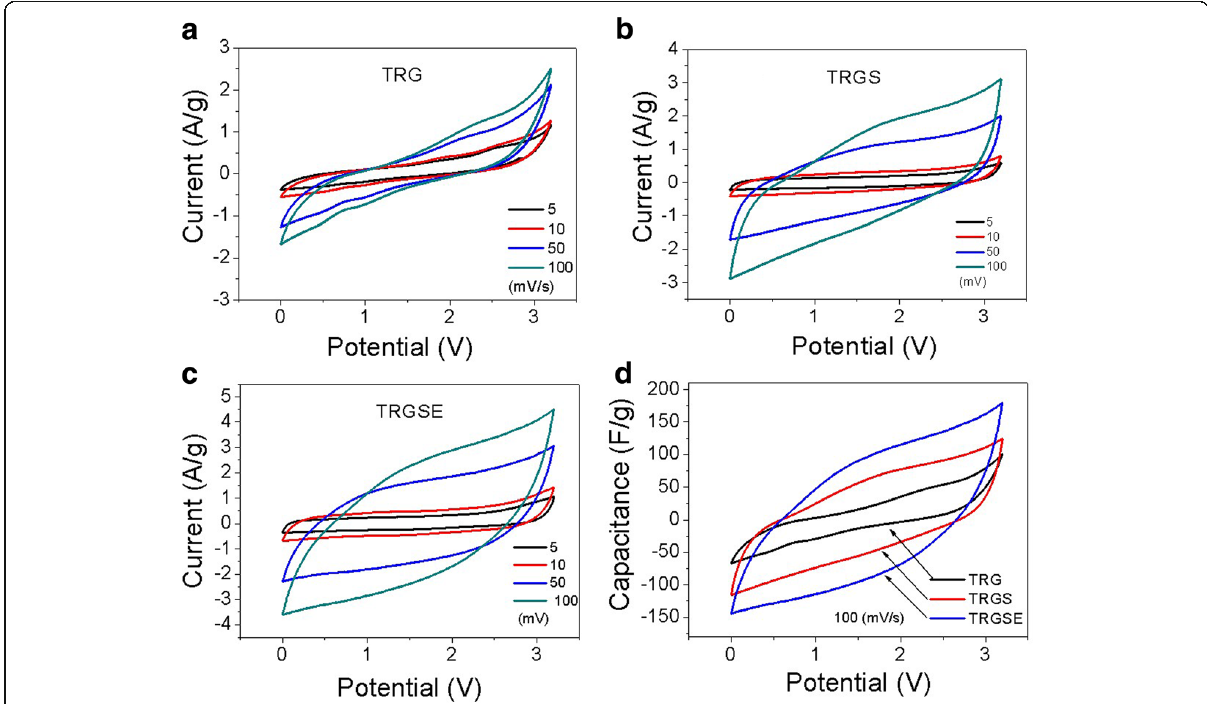
Fig. 7 Cyclic voltammetry (CV) curves of a TRG, b TRGS, and c TRGSE cells at the various voltage scan rate and d the specific capacitance Cs response of the cells calculated following Cs = (4 × I )/( d V/d t × m); d V/dt is the voltage scan rate, and m is the total weight of active materials on two